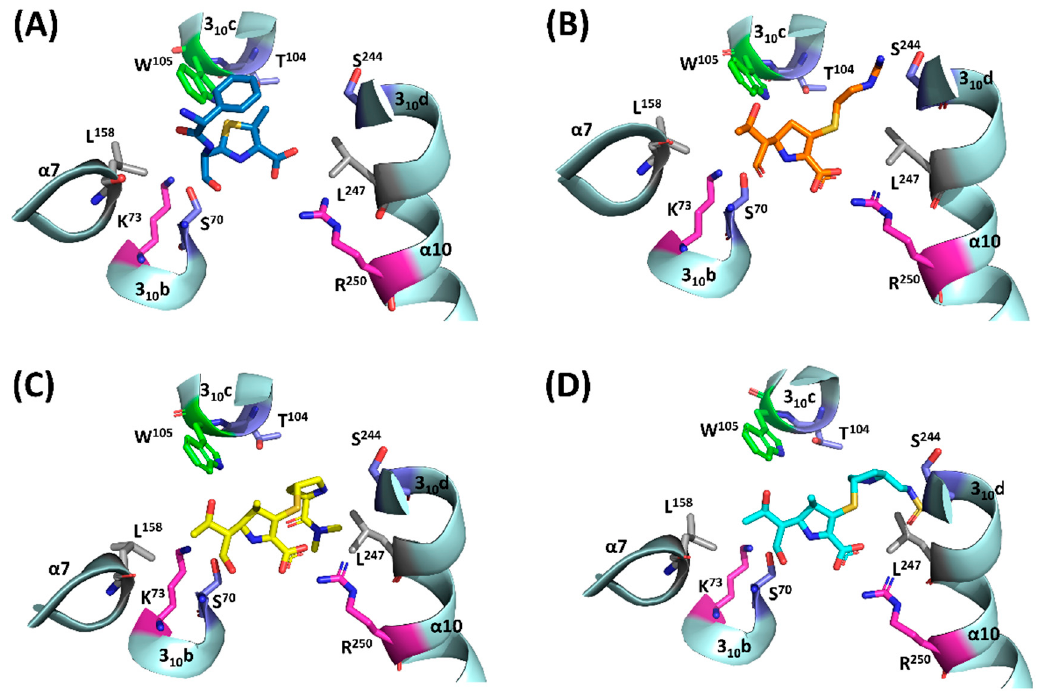
Figure 4. Overview of residues of OXA-48 involved in binding to different antibiotics. ( A ) Ampicillin (blue) was modelled in the active site of OXA-48, ( B ) imipenem (orange, 6P97) in the active site of OXA-48; ( C ) meropenem (yellow, 6P98) in the active site of OXA-48; ( D ) doripenem (cyan, 6P9C) in the active site of OXA-48.